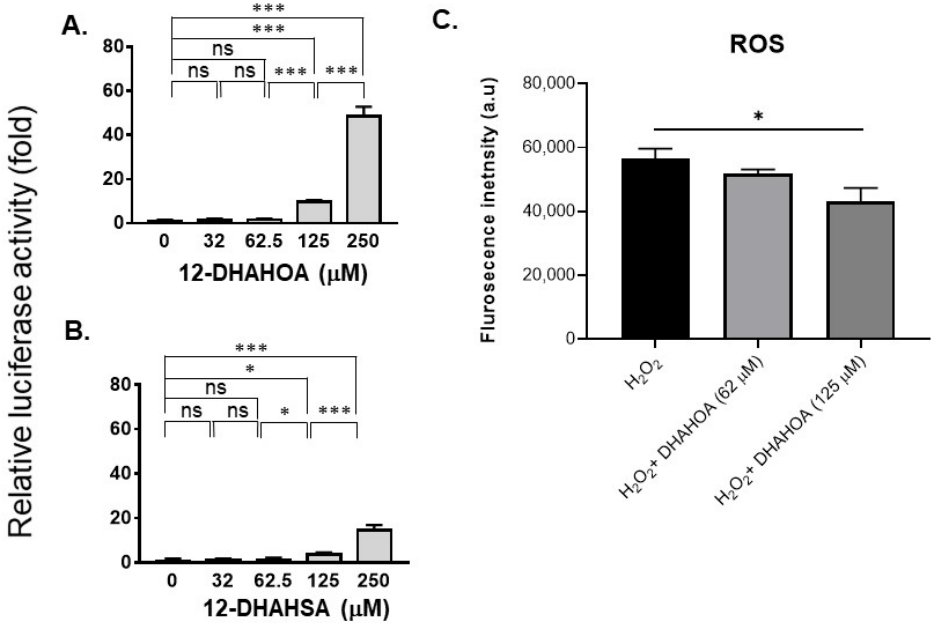
Figure 3. Evaluation of the antioxidant potential of DHA-derived FAHFAs in C3A cells. Reporter gene assay results of 12-DHAHOA ( A ) and 12-DHAHSA ( B ) treatment. ( C ) The fluorescence intensity responses to oxidative stress induced by H 2 O 2 and the effect of 12-DHAHOA treatment. * p < 0.05, *** p < 0.001, ns: not significant (one-way ANOVA) ( n = 6, mean ± SEM).